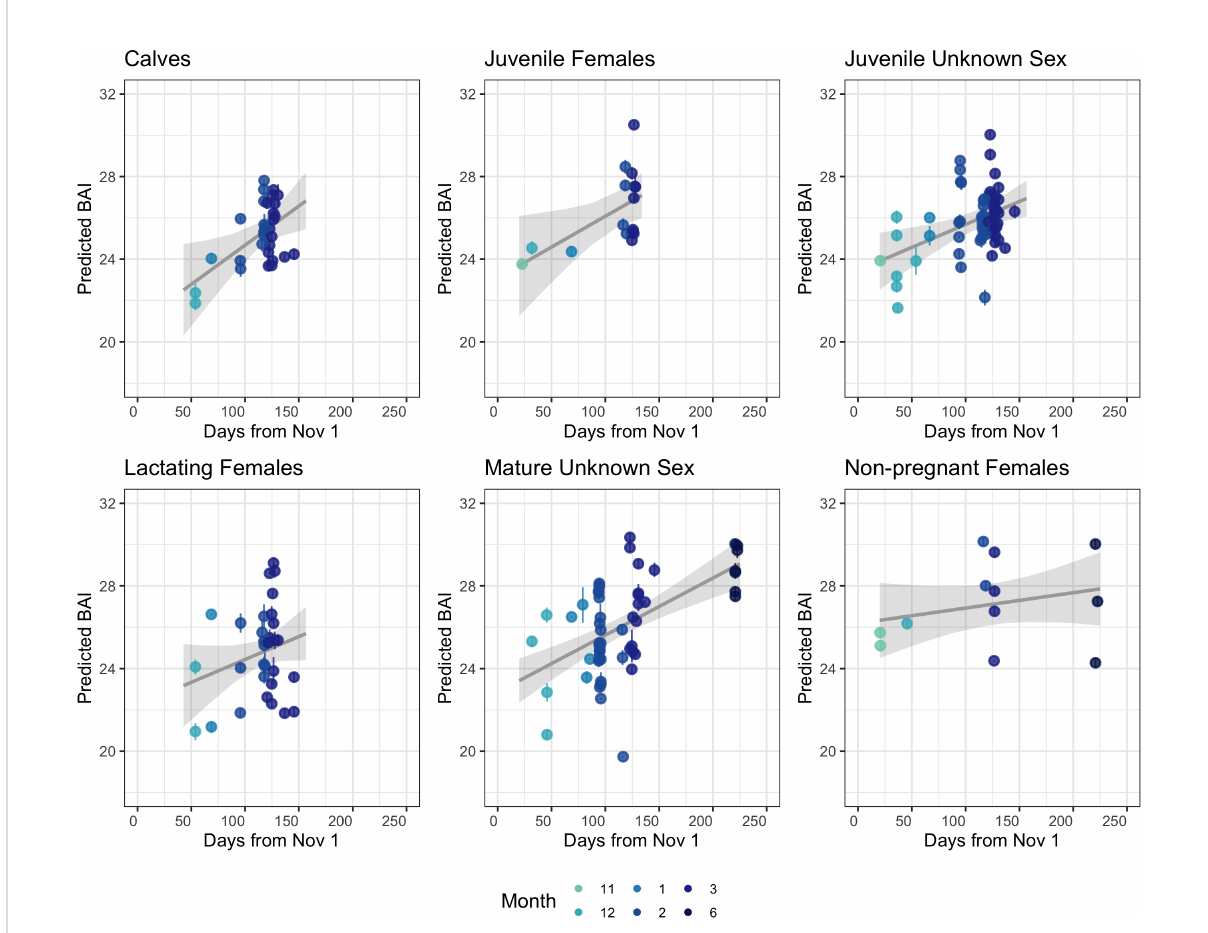
FIGURE 3 BAI change over the foraging season for each reproductive class of humpback whales sampled along the WAP. Each point represents the mean of the posterior predictive distribution for BAI for an individual whale and the error bars represent uncertainty as the 95% highest posterior density (HPD) intervals. The grey line is the estimated linear relationship, with the grey band indicating the 95% credible interval for the estimated relationship. Mature males, pregnant females, and the single pregnant & lactating female are not shown due to low samples sizes across each month (Table